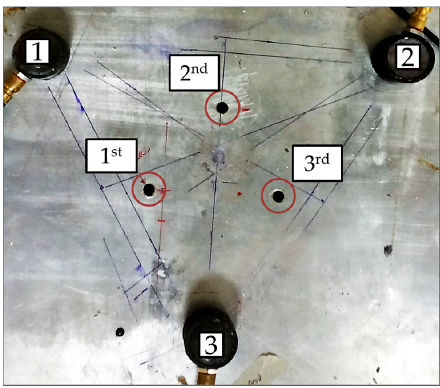
Figure 7. Experimental setup used in this paper. The omnidirectional SH 0 transducers are identified with Numbers 1, 2, and 3. The through-thickness holes were drilled successively to ensure that the wave field for each condition was saved.